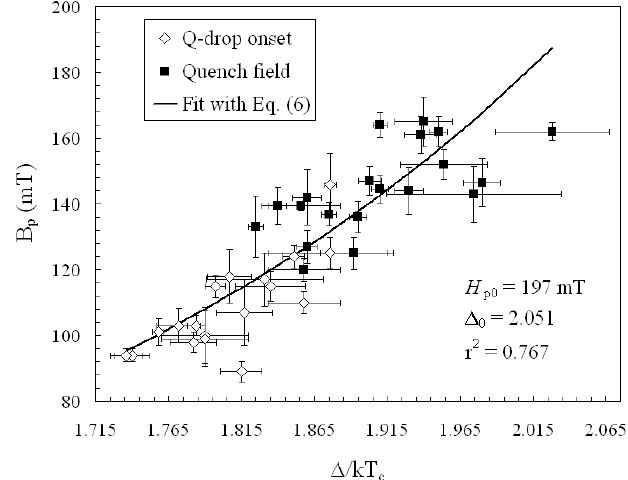
FIG. 18. B values at 2 K corresponding to the onset of Q -drop p or quench as a function of (cid:2) =kT and (cid:2) as fit parameters. 0